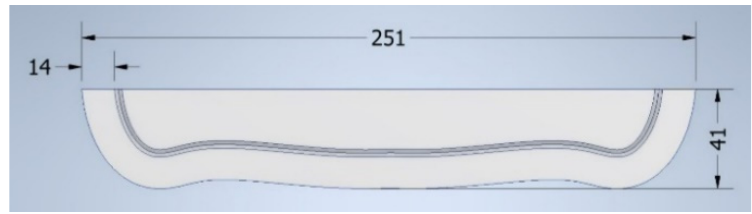
Figure 28. The model no. 4.